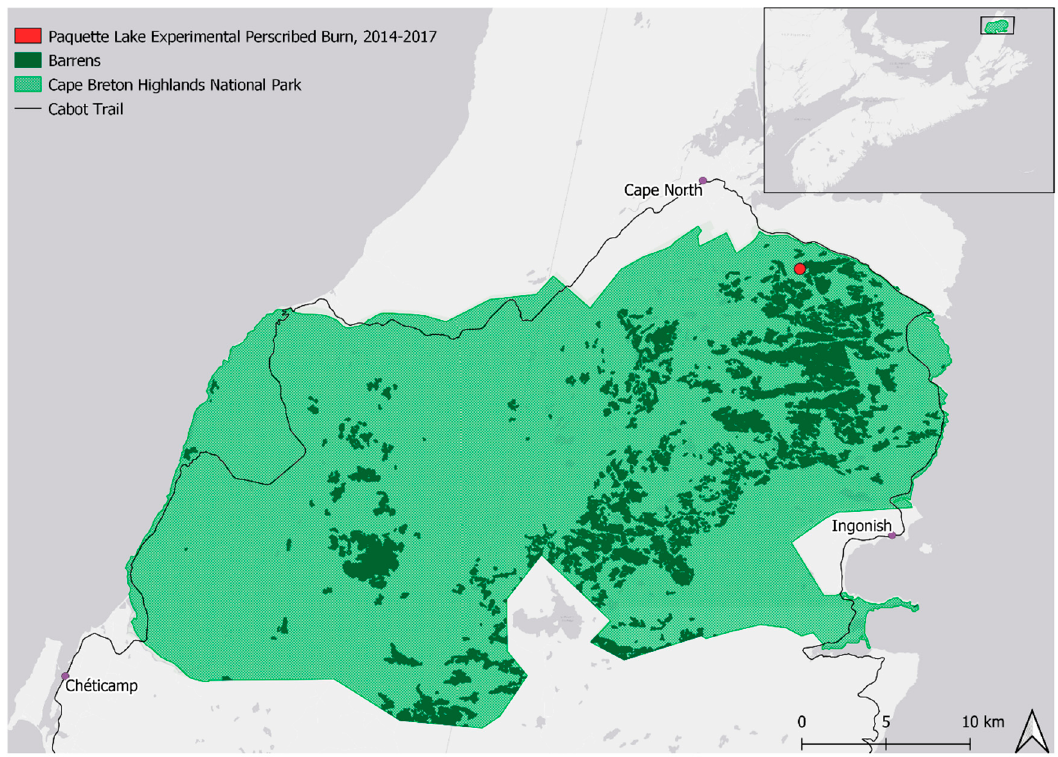
Figure 1. Extent of shrub barrens in Cape Breton Highlands National Park (CBHNP), Paquette Lake Experimental Prescribed Burn Site.